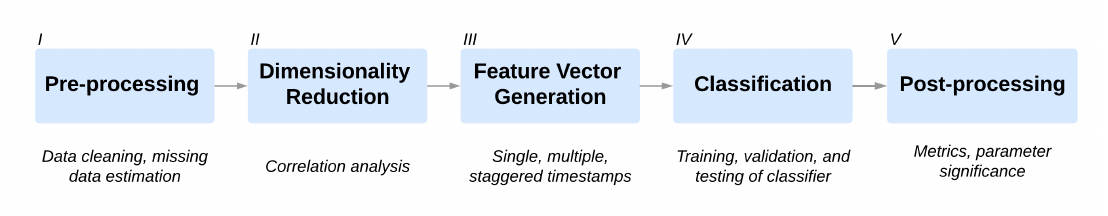
Figure 2. Various steps in the SAFE framework for critical parameter identification.